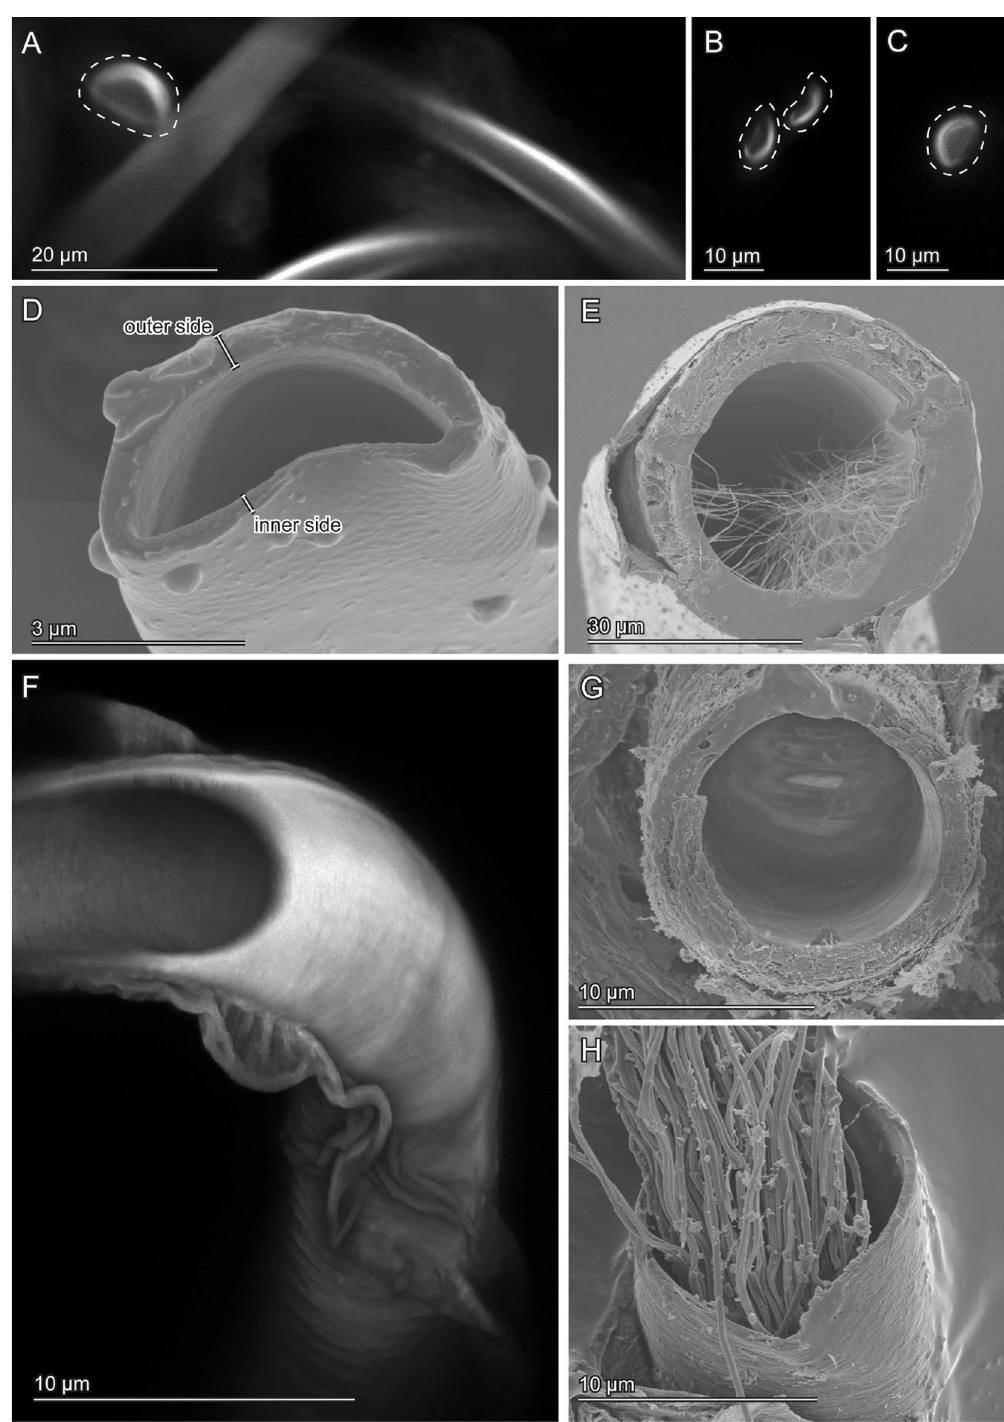
Figure 5. Geometry of the virga and spermatheca of Echinosoma horridum . Confocal laser scanning micrographs ( A – C , F ) and scanning electron micrographs ( D , E , G , H ). ( A – C ) Optical slices of the thin-tube of the virga taken using CLSM. Cross-sections are enclosed with broken lines. ( D ) A cross-section of the thin-tube of the virga. The cross-section was visualised by cutting the thin-tube with micro scissors that caused slight deformation (cf. images A – C ). ( E ) A cross-section of the thick-part of the virga. Microtrichia in the lumen are visible. ( F ) The thick-part of the virga. A maximum intensity projection. A distal part is optically cut so that the hollow inside is also visible. ( G , H ) Cross-sections of the spermatheca. Spermatozoa are visible ( H